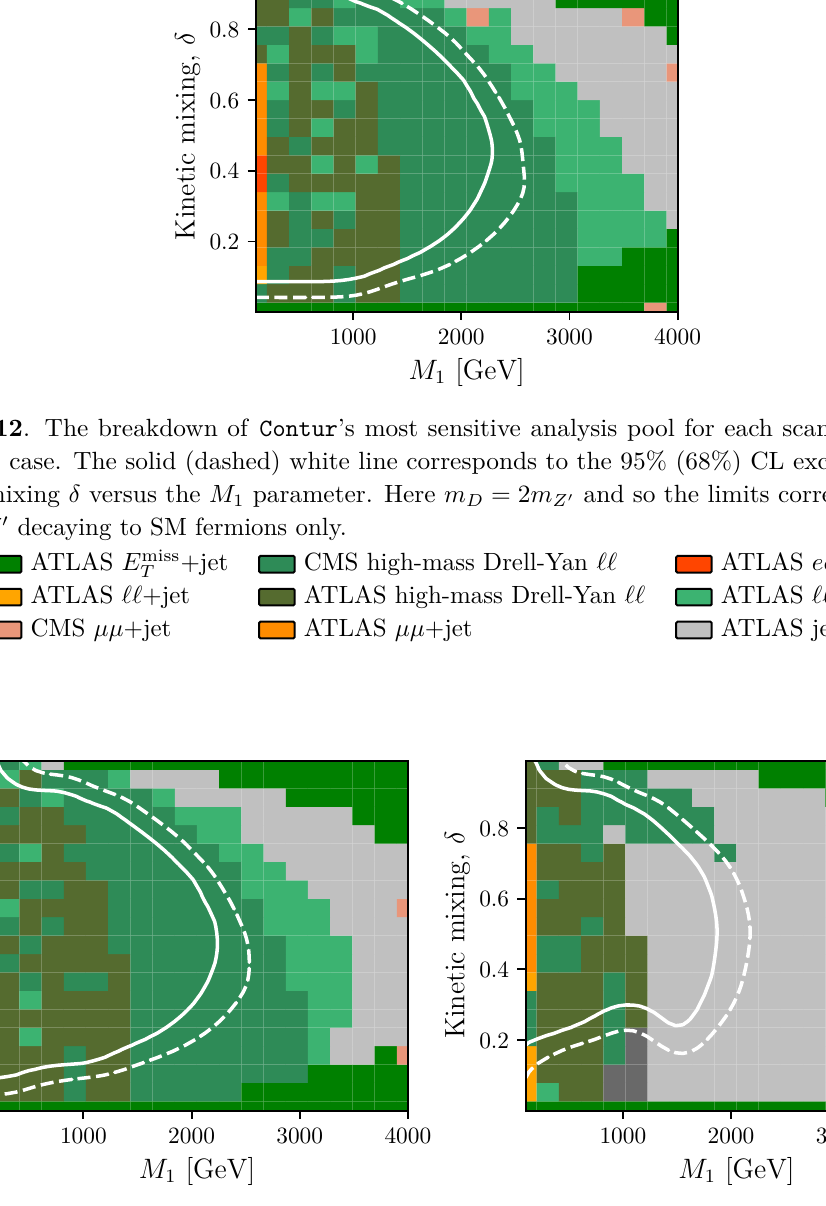
Figure 13 . The 95% CL (solid) and the 68% CL (dashed line) exclusions on the kinetic mixing δ versus the M 1 parameter for the case of heavy Z 0 invisible decay to DM fermions and for different values of g X . The left panel corresponds to g X = 0 . 1 while the right panel corresponds to g X = 1 . 0 . We take m D = m Z 0 / 4 . The colored bins correspond to the pool of analyses giving the dominant